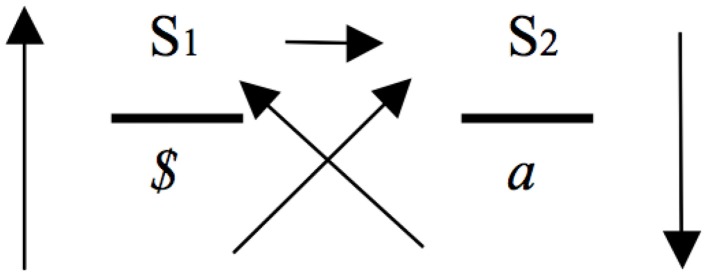
Discourse of the master (based on: Lacan, 1972, p. 40).